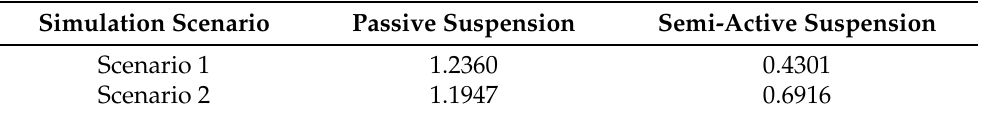
Table 6 summarizes the comfort evaluation for the two performed simulation scenarios. Table 6. RMS acceleration (m/s 2